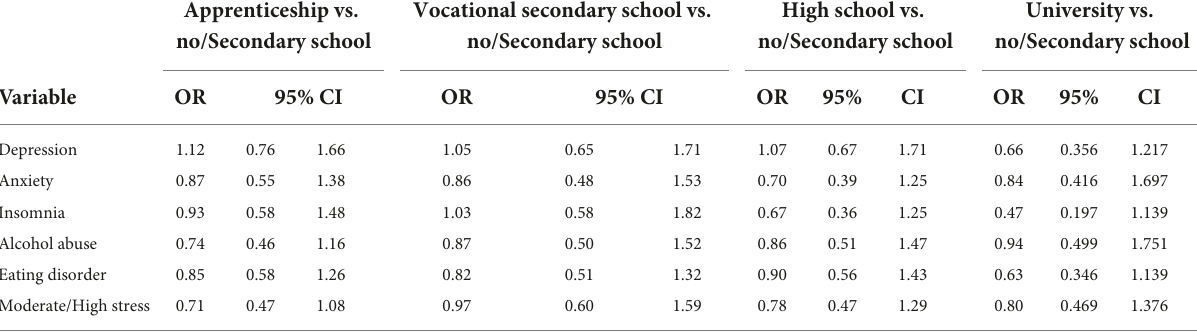
TABLE 4 Adjusted odds ratios (ORs) stratified by education with the education category “no or secondary school” being the reference. Apprenticeship vs.